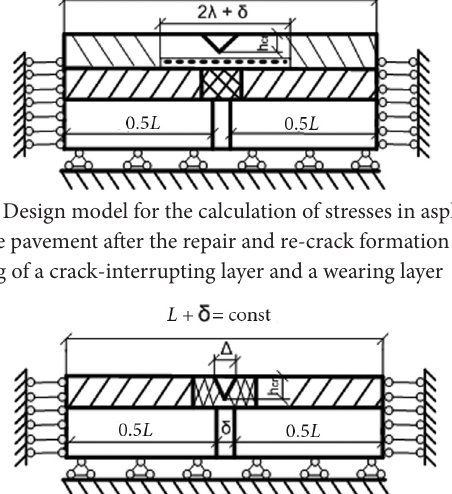
Fig. 9. Design model for the calculation of stresses in asphalt concrete pavement after repairing activities after milling and sealing cracks in asphalt concrete layer on a cracked basis